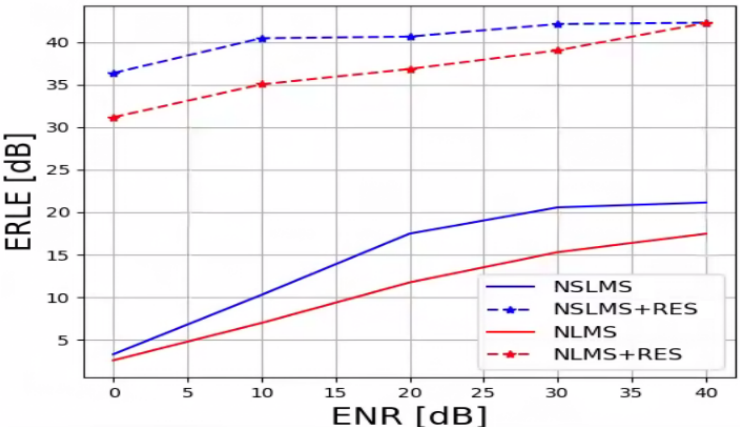
Figure 7. ERLE in far-end-only scenarios for different